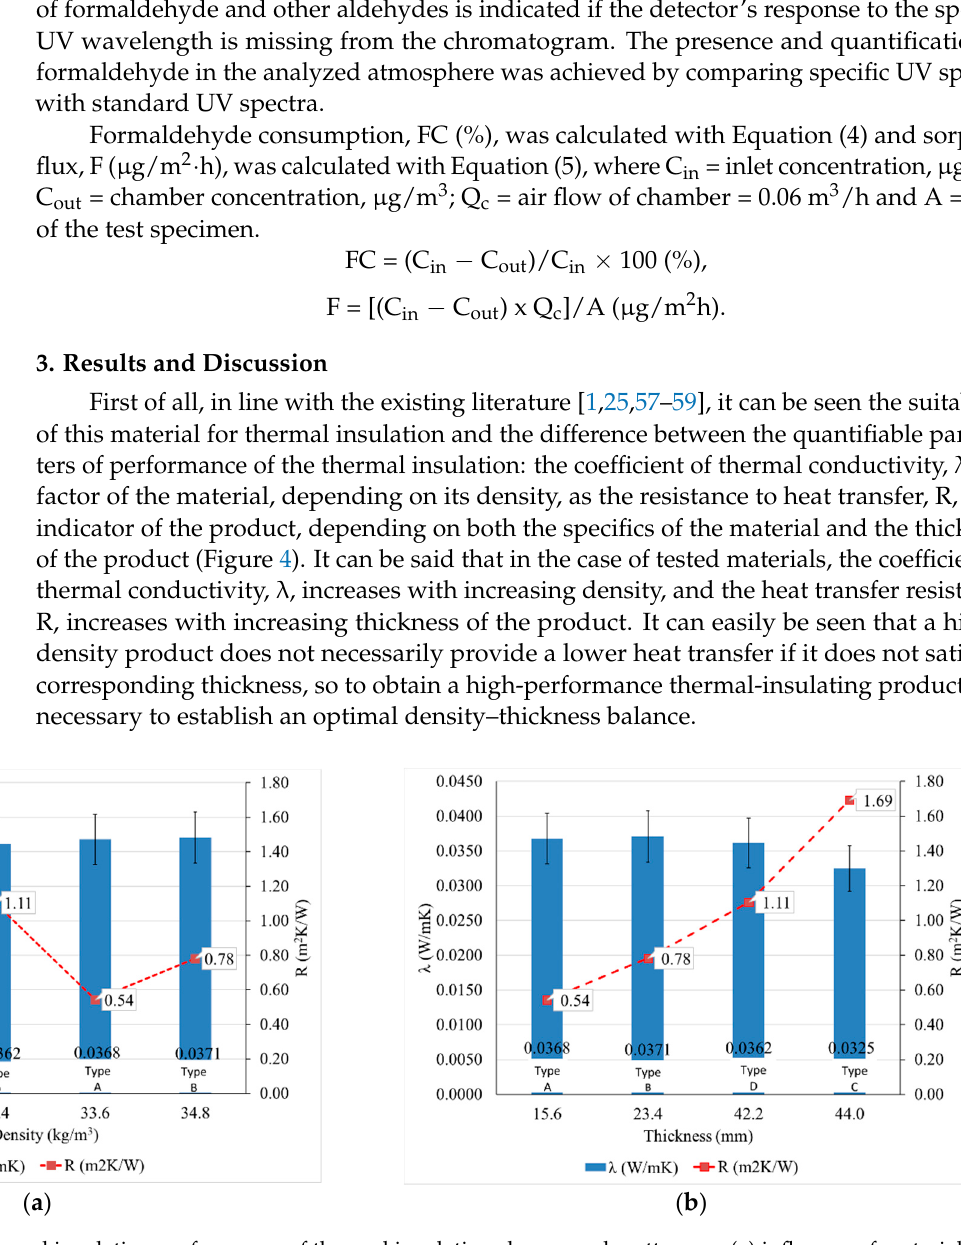
Figure 4. Analysis of thermal insulation performance of thermal insulation sheep wool mattresses: ( a ) influence of material density; ( b ) influence of the thickness of the thermal-insulating mattress (Types A, B, C, D defined according to Table 2).